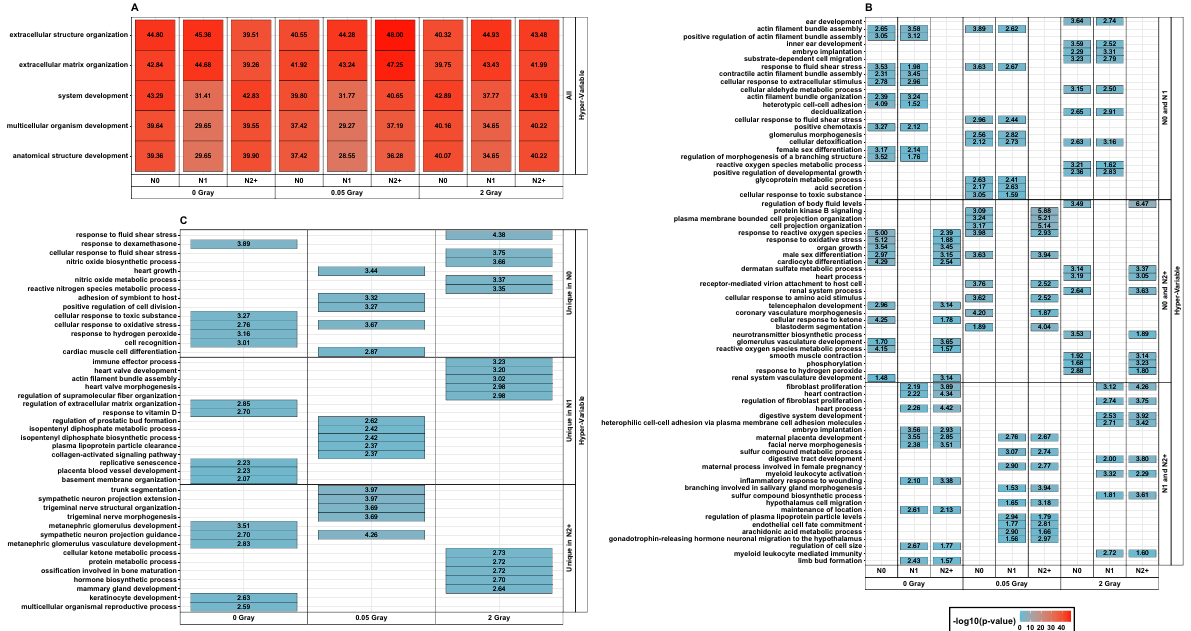
Fig. 3 Summary of the top 5 Gene Ontology terms regarding the adjusted p ‑value: stratified by group‑wise overlap (Top 5 in A ) all groups, B overlap of two donor groups, and C unique in one group), per radiation dose for genes classified as hypo‑variable. Inside the tiles, each respective adjusted ‑log 10 ( p ‑value) is provided. Since a p ‑value was computed per group for A and B , the top 5 GO terms e.g., found only in N0 and N1, but not in N2 post‑HDIR might differ. In this case, the top 5 for N0 and N1 are shown each, resulting in more than 5 terms. N0 + of cancer‑free controls, N1 fibroblasts of long‑term survivors of childhood cancer without a second primary neoplasm, N2 = long‑term survivors of childhood cancer with at least one second primary